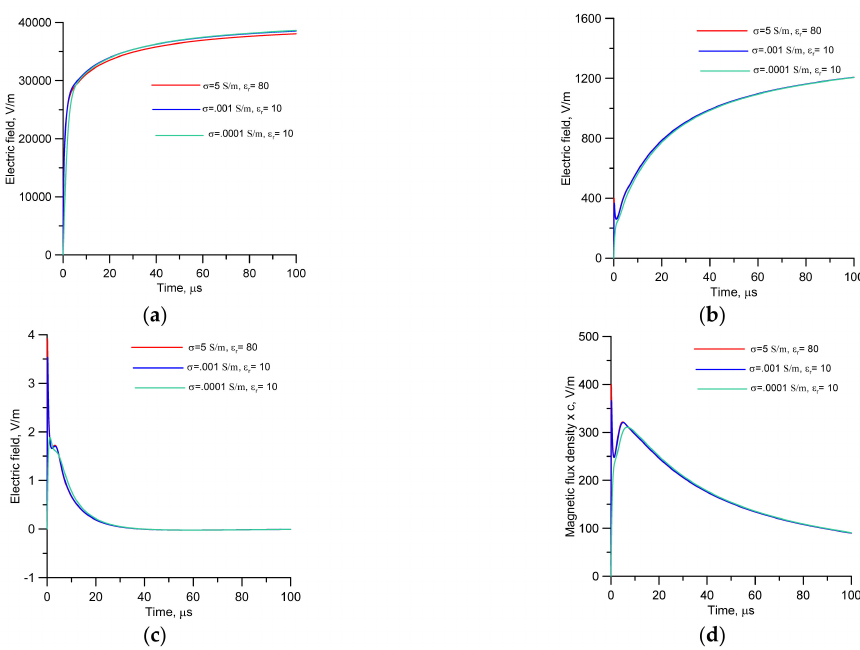
Figure 7. The source electric and magnetic fields generated by a subsequent return stroke of 12 kA for three sets of electric parameters at the strike point. ( a ) Electric field at 50 m, ( b ) electric field at 1 km, ( c ) electric field at 100 km, and ( d ) magnetic field at 1 km (note that the parameter depicted is the product of the magnetic field and the speed of light).